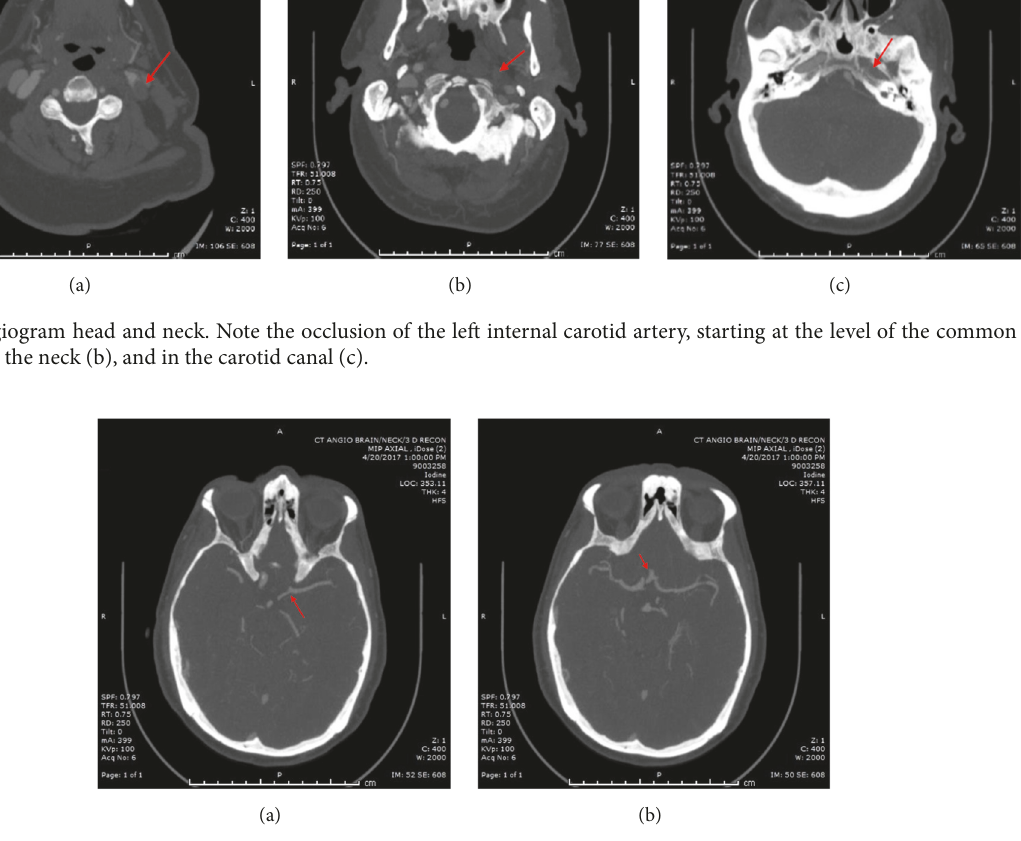
Figure 2: CT angiogram head and neck (continued): note the absence of the left internal carotid artery intracranially and poor opacification of the left ophthalmic artery. There is collateral supply to the left middle cerebral artery from the left posterior cerebral artery (a) and the anterior communicating artery (b). An intact circle of Willis allowed the left middle cerebral artery to maintain supply despite the complete occlusion of the left internal carotid